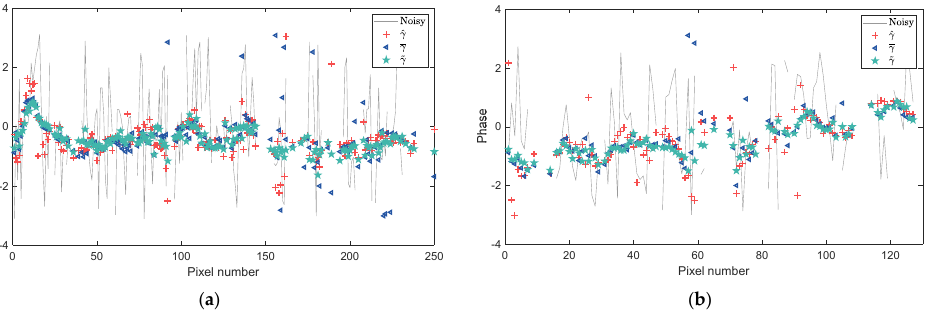
Figure 12. ( a ) Horizontal and ( b ) vertical profiles of original and reconstructed interferometric phases along solid black lines depicted in Figure 11a.